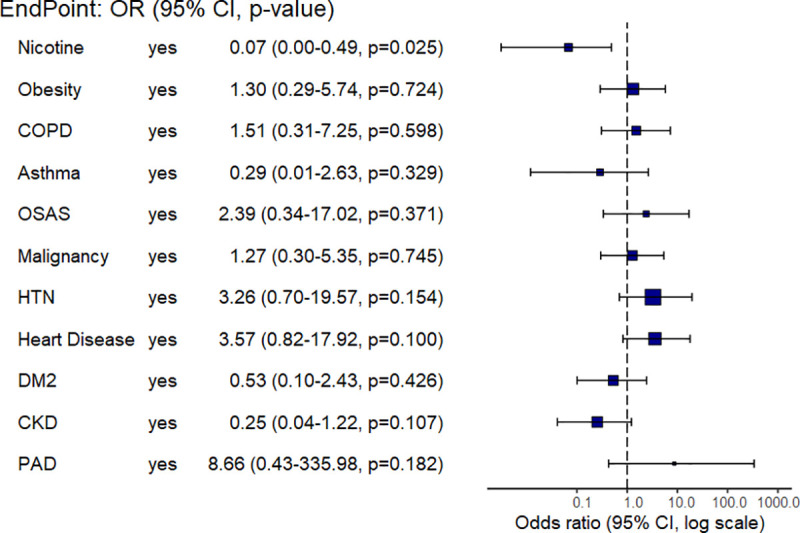
The potential effect of risk factors on patient outcome.Plot of logistic regression with adjusted Odds Ratio (point estimate and 95% CI) of different risk factors (logistic regression by means of base R Generalized Linear Model(glm)). COPD: chronic obstructive lung disease, OSAS: obstructive sleep apnea syndrome, HTN: hypertension, DM2: type 2 diabetes mellitus, CKD: chronic kidney disease, PAD: peripheral artery disease.